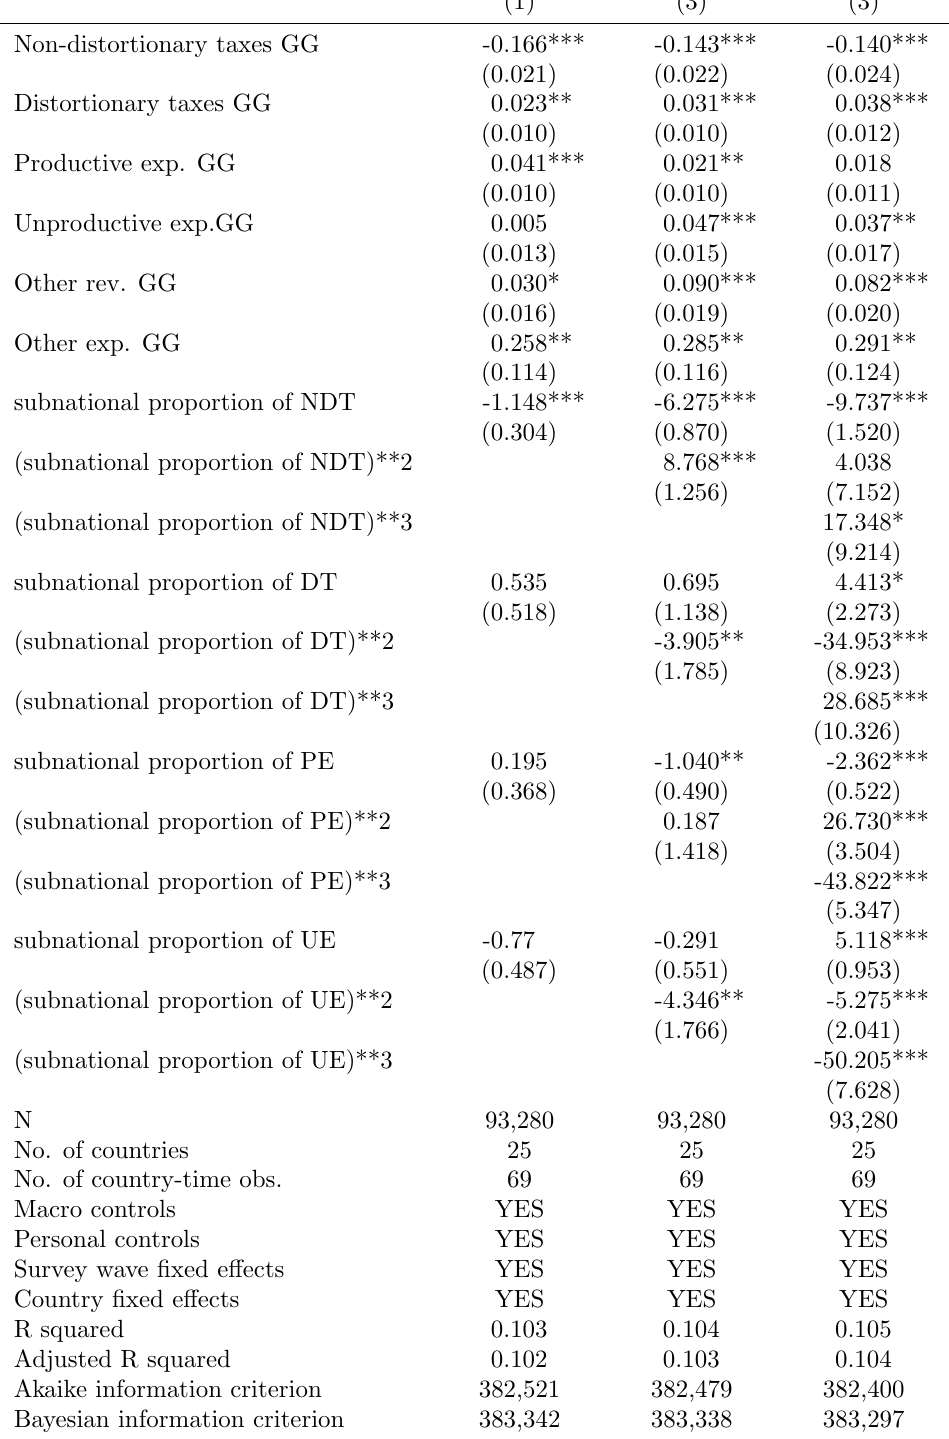
Table A.6: Subnational government